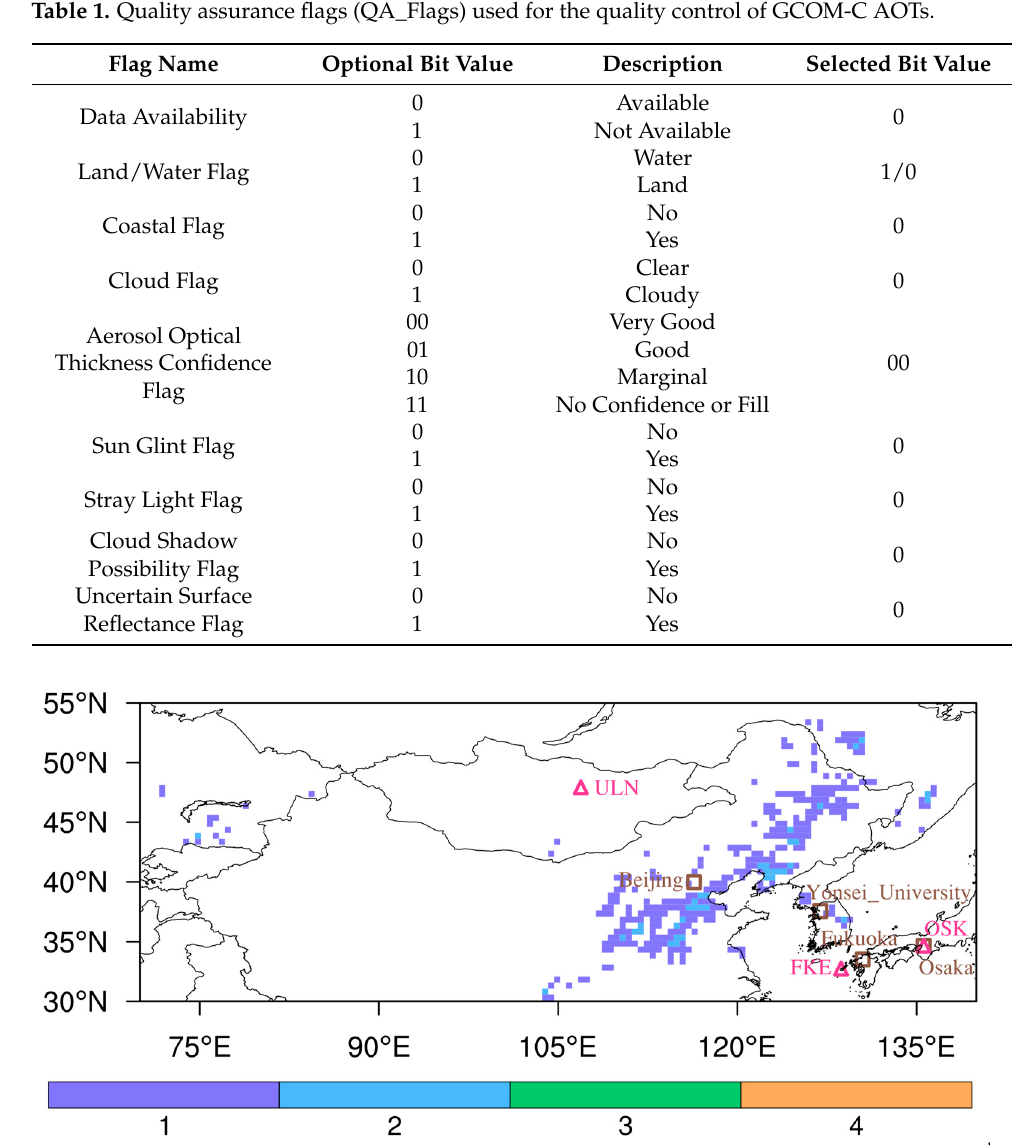
Figure 1. Number of hourly GCOM-C AOTs at 500 nm from 28 to 31 March 2018 for aerosol data assimilation over East Asia. Brown squares and pink triangles represent the locations of observation sites from the Aerosol Robotic Network (AERONET) and Asian Dust and Aerosol Lidar Observation Network (AD-Net), respectively, for independent validation. Table 1. Quality assurance flags (QA_Flags) used for the quality control of GCOM-C AOTs.